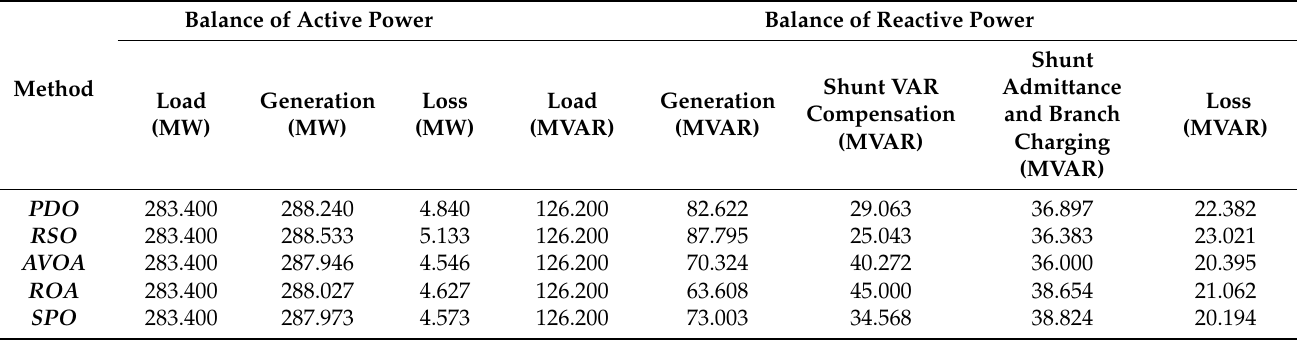
Figure 8. The AVOA voltage profile with the other compared methods for case 3. Table 13. Balance of active and reactive power for proposed algorithms with case 3.